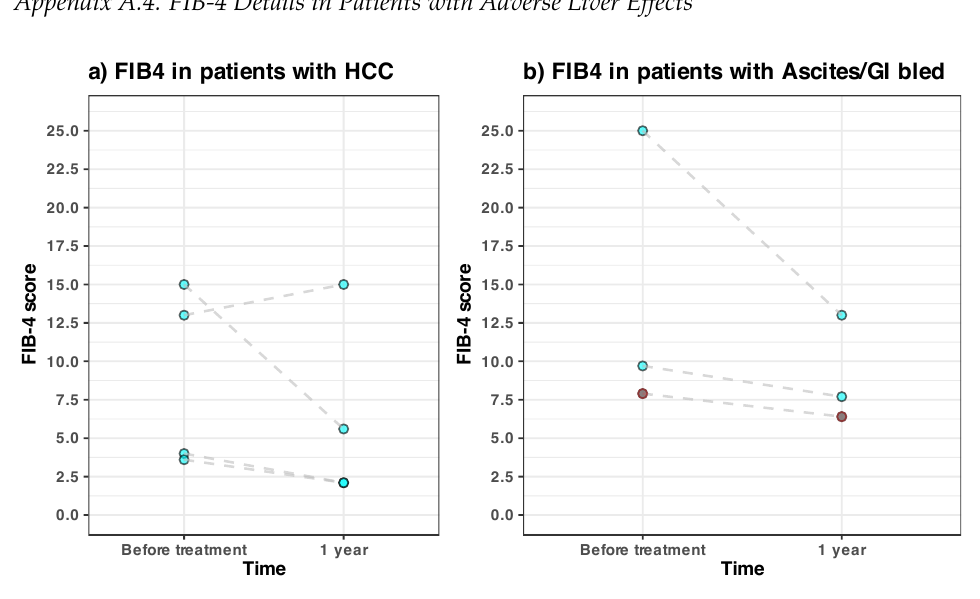
Figure A1. ( a ) The individual FIB-4 scores for patients with ( a ) hepatocellular carcinoma and ( b ) with ascites/GI bleeding, measured before and 1 year after the treatment. The brown dots in ( b ) represent the FIB-4 values of the patient that died during the 2nd year of